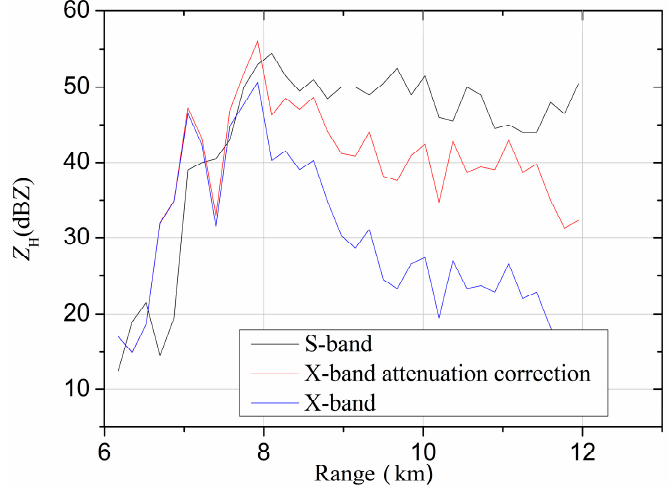
Figure 6. The Z H of the X-band PAR before (blue) and after (red) attenuation correction at an azimuth of 5 deg and an elevation of 6.3 deg corresponding to Figure 5. The black line is from the S-band radar, also at an azimuth of 5 deg and an elevation of 6 deg.